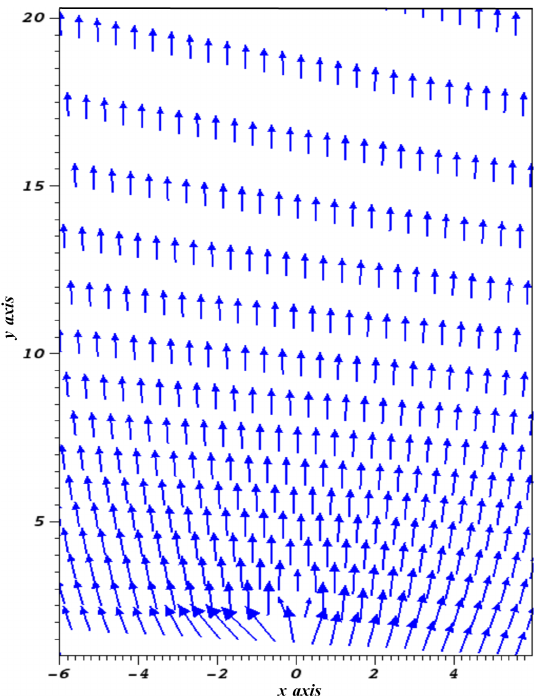
Figure 1. Equilibrium open and expanding magnetic field lines in the model quiet-Sun solar atmosphere. The x axis and the y axis are given in megametres (Mm).